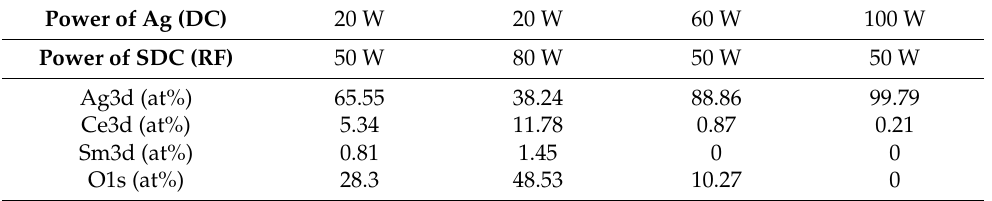
Table 1. XPS results of atomic percentages of Ag-SDC cermet with different ratios of Ag and SDC. Power of Ag (DC) Power of SDC